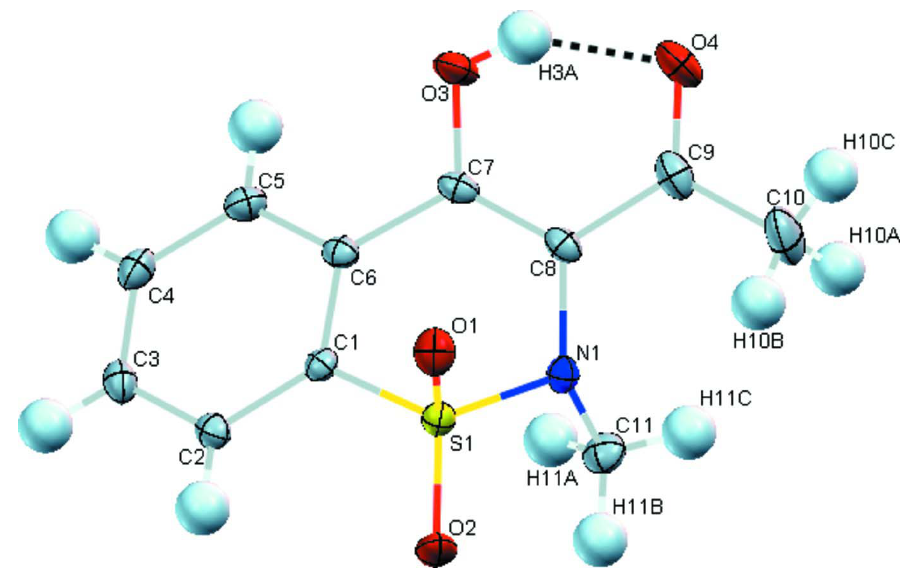
Figure 1 The molecular structure of (I), showing displacement ellipsoids at the 50% probability level for non-H atoms; dashed lines denote hydrogen